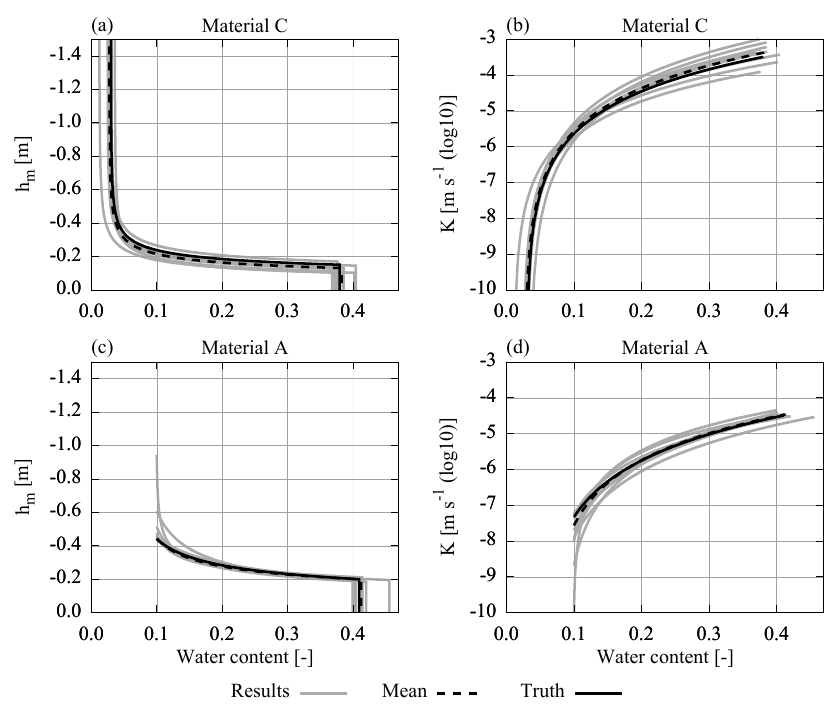
Figure 10. The resulting material parameters estimated from synthetic data are shown for the 10 best ensemble members (Sect. 3.1.2) together with the mean of these parameter sets and the true parameter set (Table 2). The plot range of the parameters is adjusted to the water content range of the data.